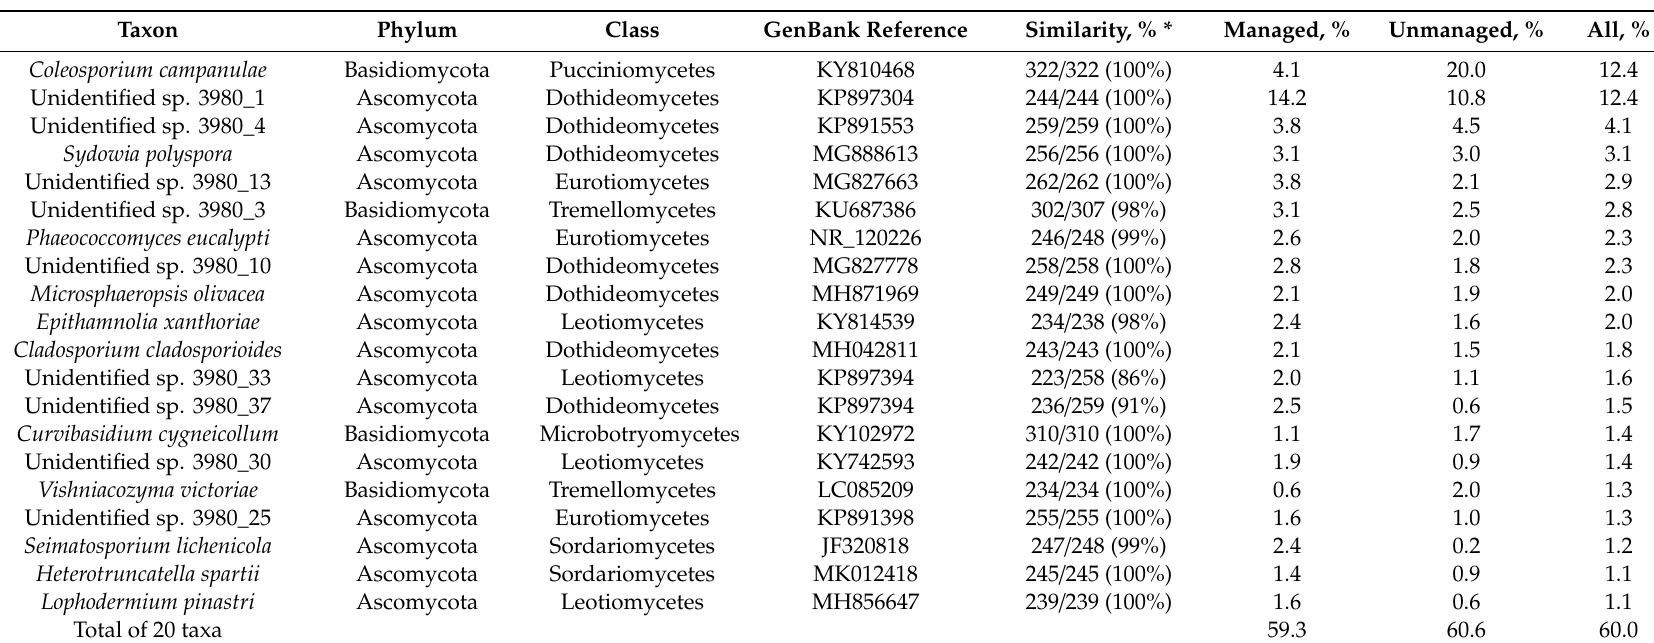
Table 3. Relative abundance of the 20 most common fungal taxa sequenced from needles of Pinus sylvestris from managed and unmanaged forest stands. Data from di ff erent sites is